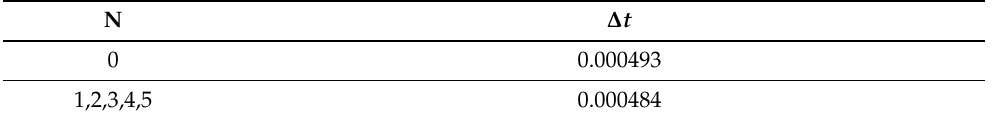
Table 9. Maximum stable time step size ∆ t for varying N , constant CFL number CFL ≈ 0.7 and ∆ x = 0.001 for smooth periodic wave test case for non-stiff